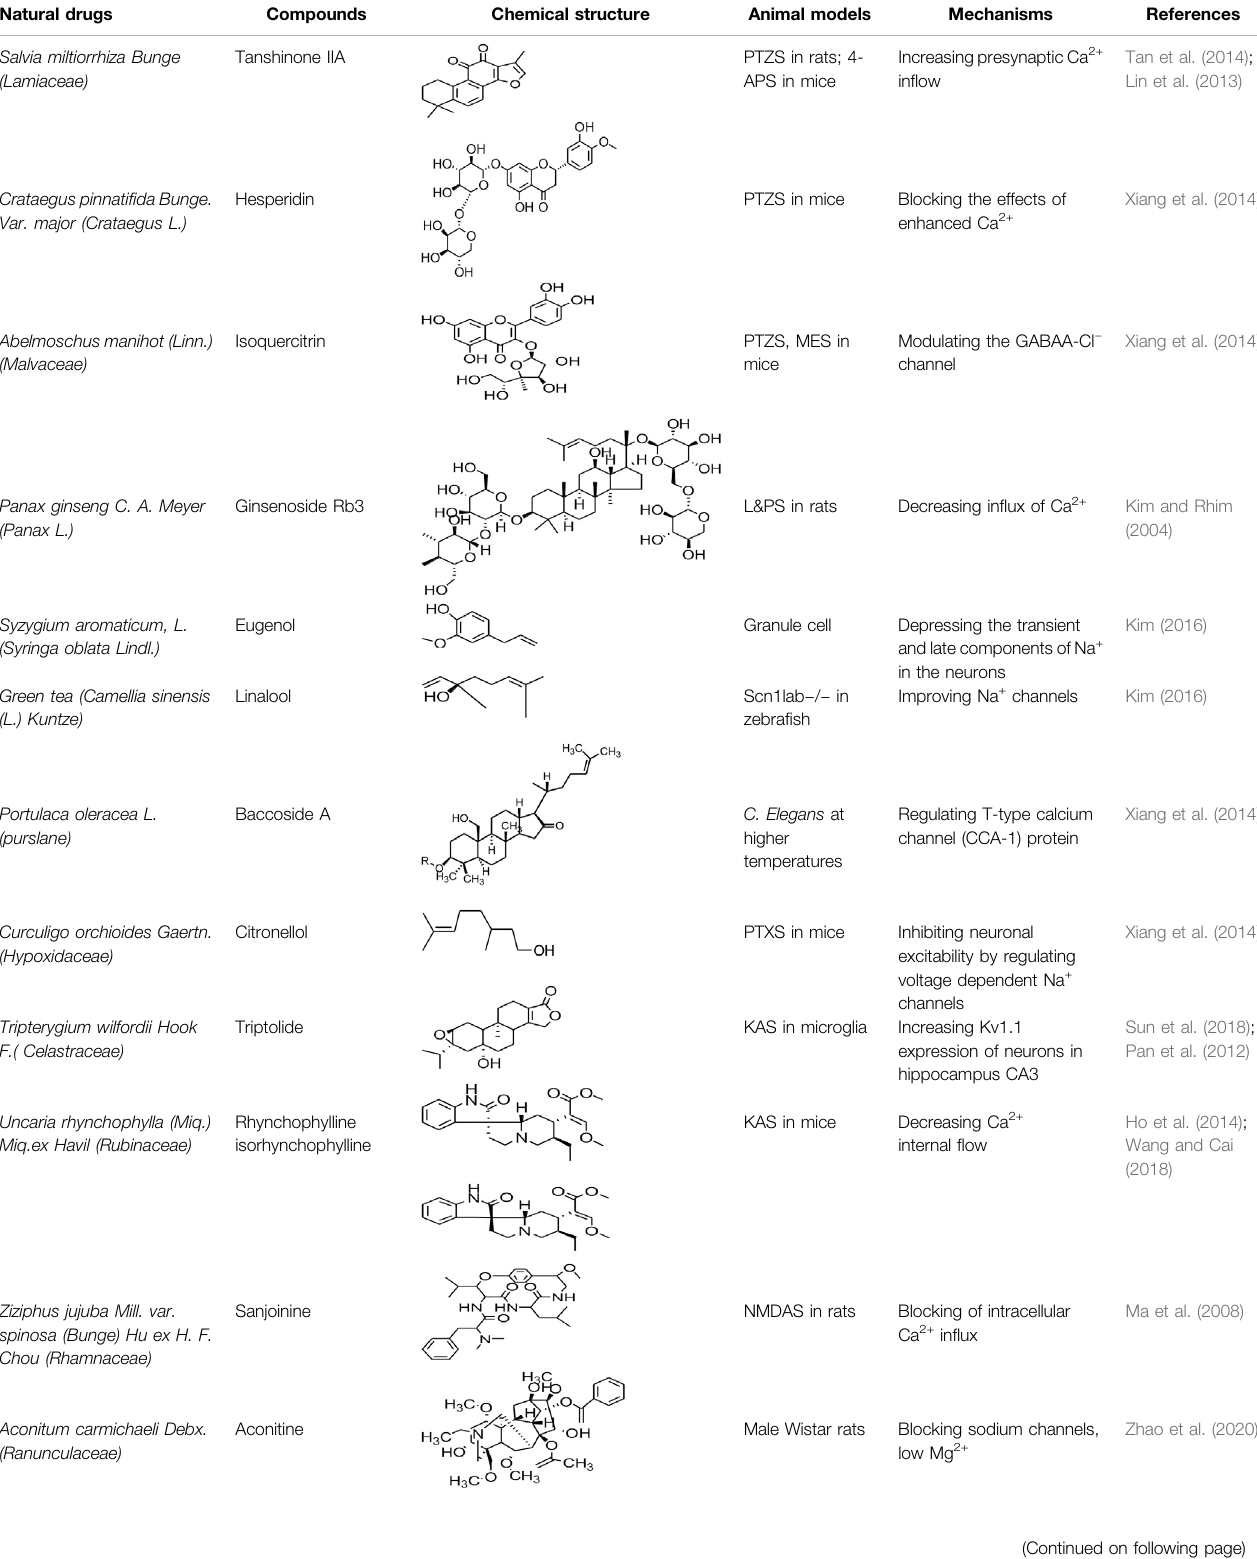
TABLE 3 | Natural drugs used to treat epilepsy by regulating the concentration of